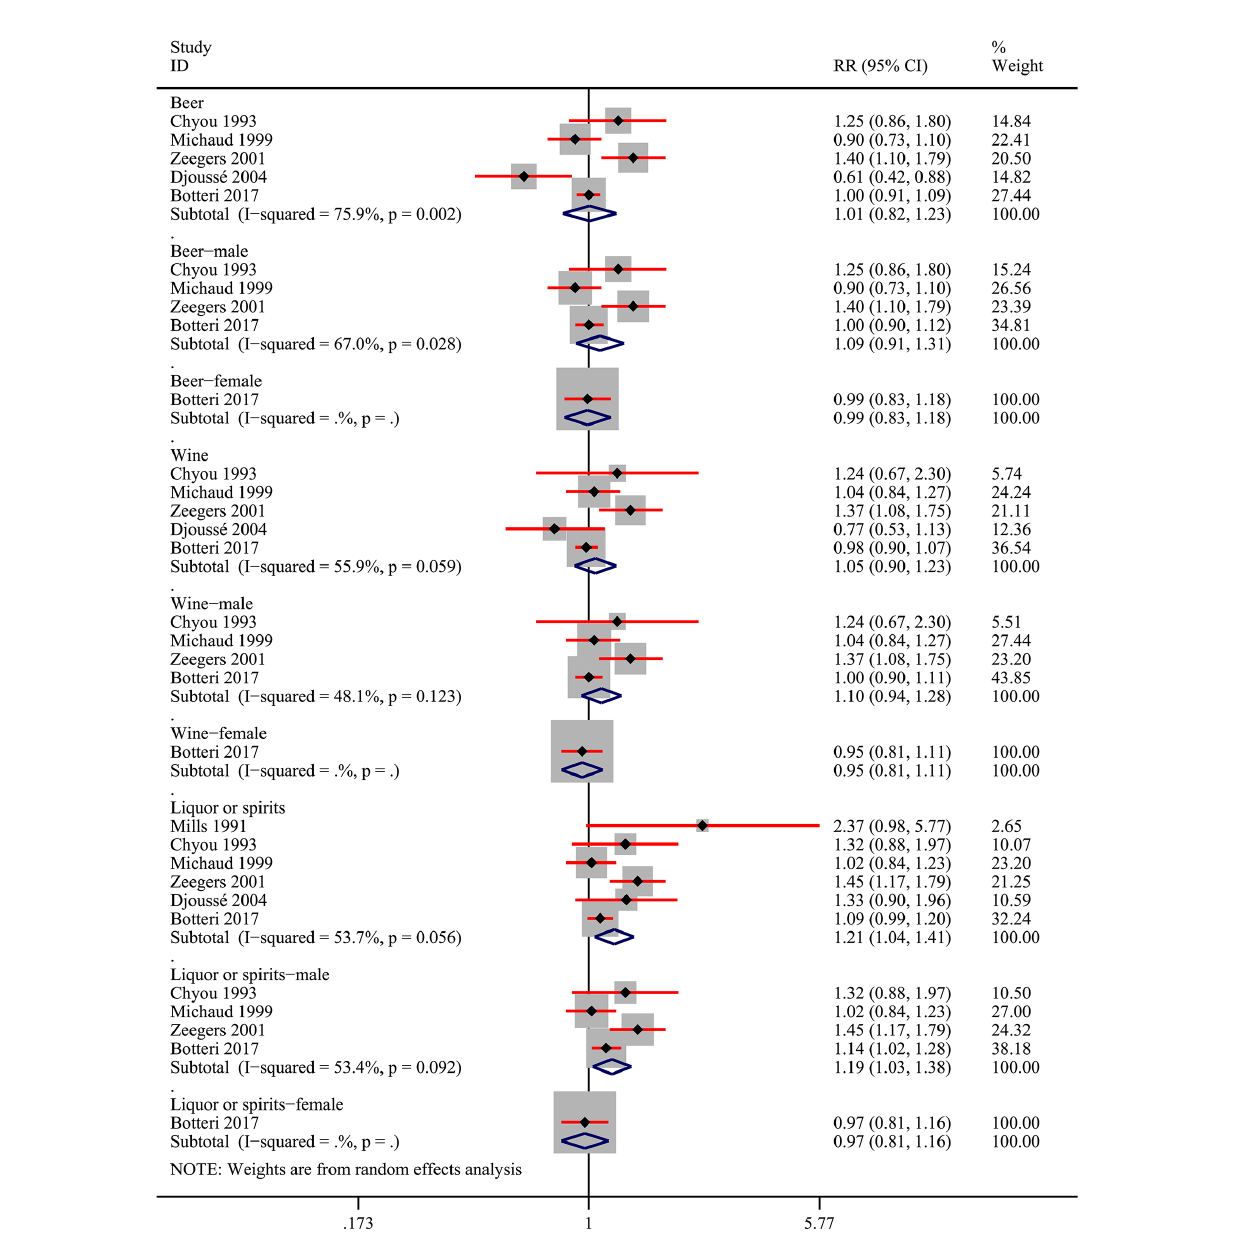
FIGURE 3 | Forest plot of relative risk (RR) of bladder cancer for alcohol consumption (Any versus none) of different sources in the entire population and different gender